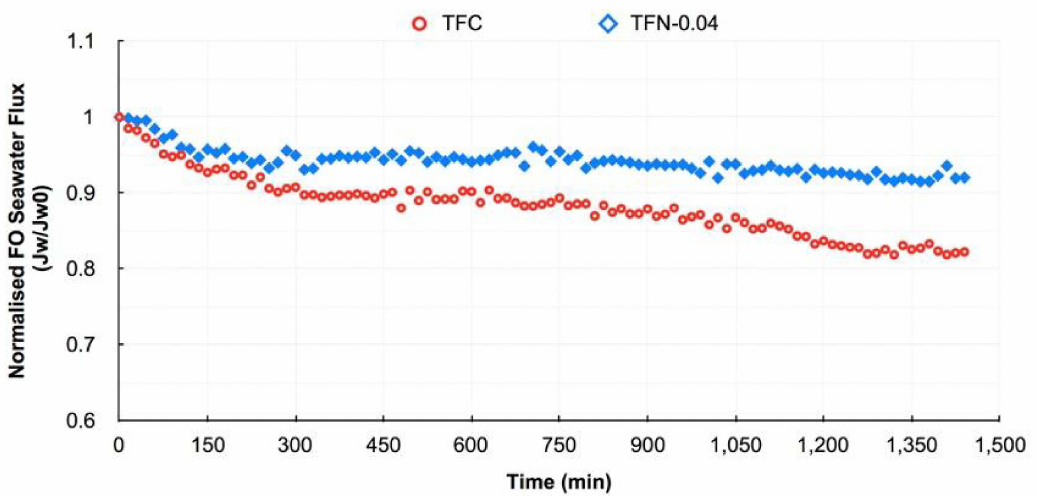
Figure 8. Normalized FO seawater flux decline of the membranes over 1-day (FS/Caspian seawater, DS/2 M NaCl, T/25 ◦ C, Mode/AL-FS). Reproduced from reference [42] with permission from Elsevier